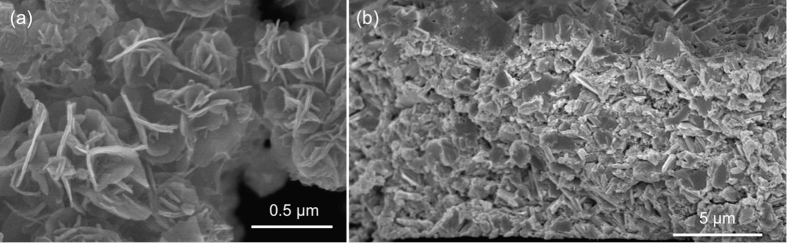
SEM images of (a) the Bi2Te2.8Se0.2 nanocrystals and (b) the cross section of a printed film on polyimide substrate.